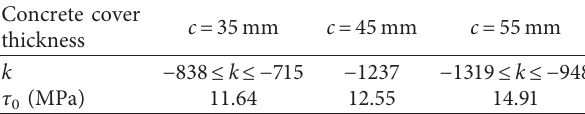
Table 9: The range of the coefficient in equation (16). Concrete